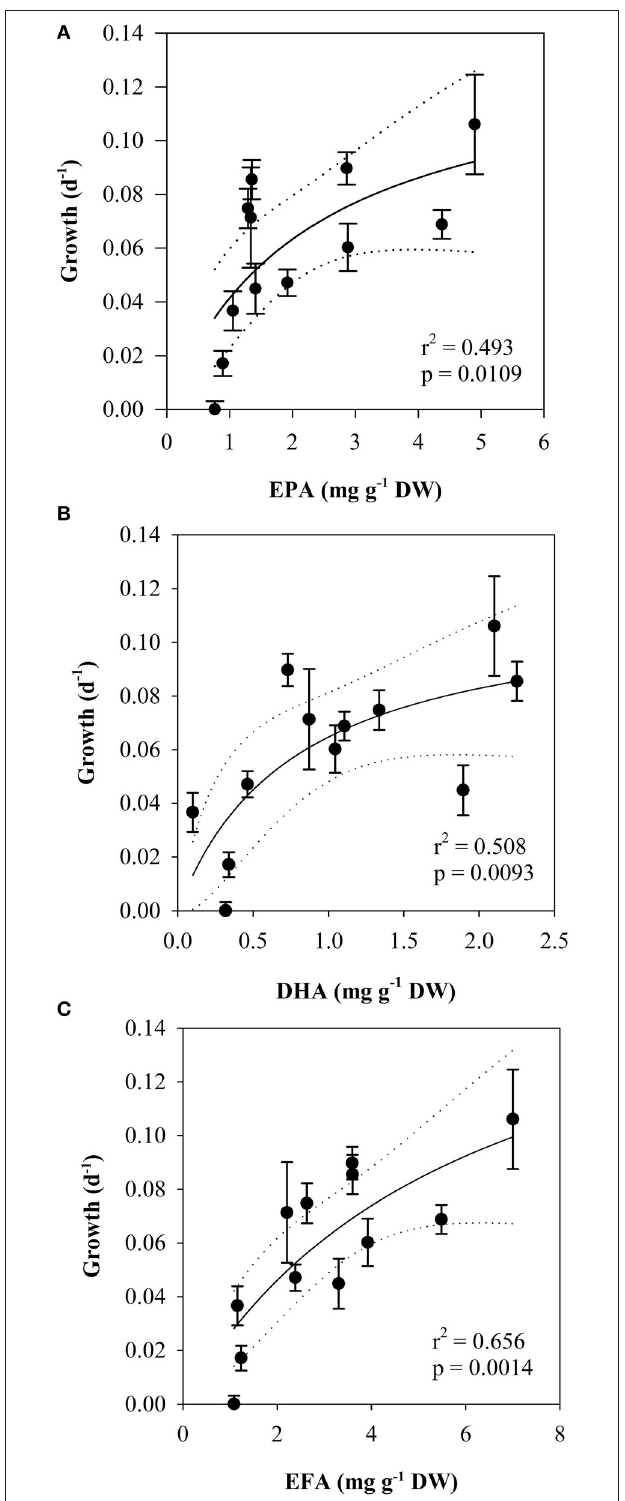
FIGURE 8 | Scatterplot of temperature-normalized growth rates (day − 1 , mean ± SE) of nauplii vs. (A): the content of EPA, (B): the content of DHA and (C): the content of EFA in the seston (mg g DW − 1 ). Lines indicate regressions (2-parameter hyperbola) with 95% confidence intervals.